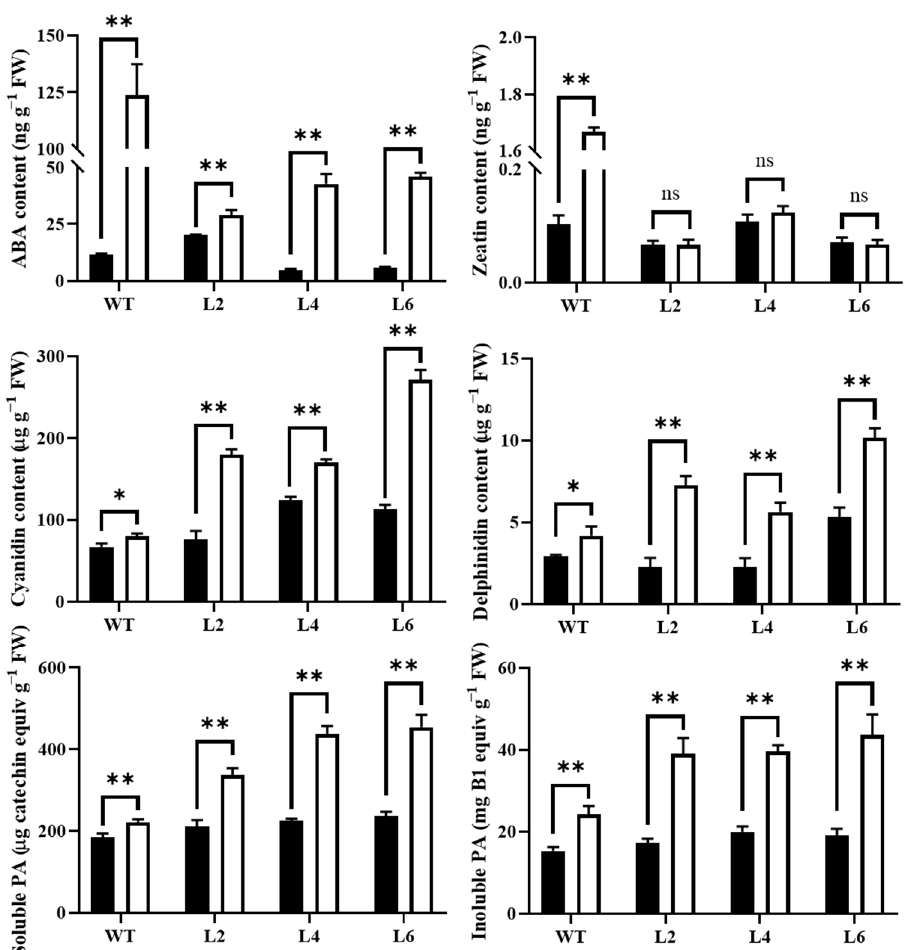
Figure 9. Abscisic acid (ABA), zeatin, cyanidin, delphinidin, and proanthocyanidin (PA) contents in leaves of TaPsb28 -overexpressing Arabidopsis seedlings in response to drought stress. The black column represents the plants treated by normal watering, while the white column represents the plants subjected to drought stress by withholding irrigation for 14 days. Data are expressed as the means ± SDs ( n = 3). “**” and “*” indicate statistically significant differences between the CK and drought treatments at p < 0.01 and 0.05, respectively, while “ns” represents nonsignificant differences between the two treatments at the level of p < 0.05.